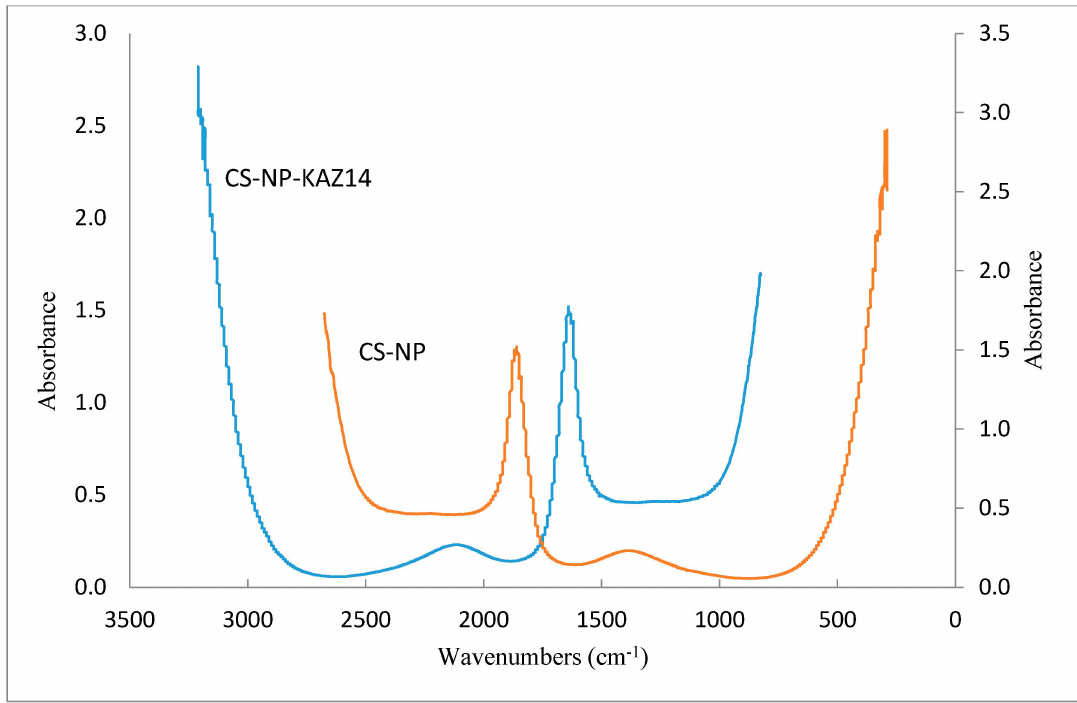
Figure 2. Fourier transform infrared (FT-IR) spectra of blank C-NP and C- Φ KAZ14